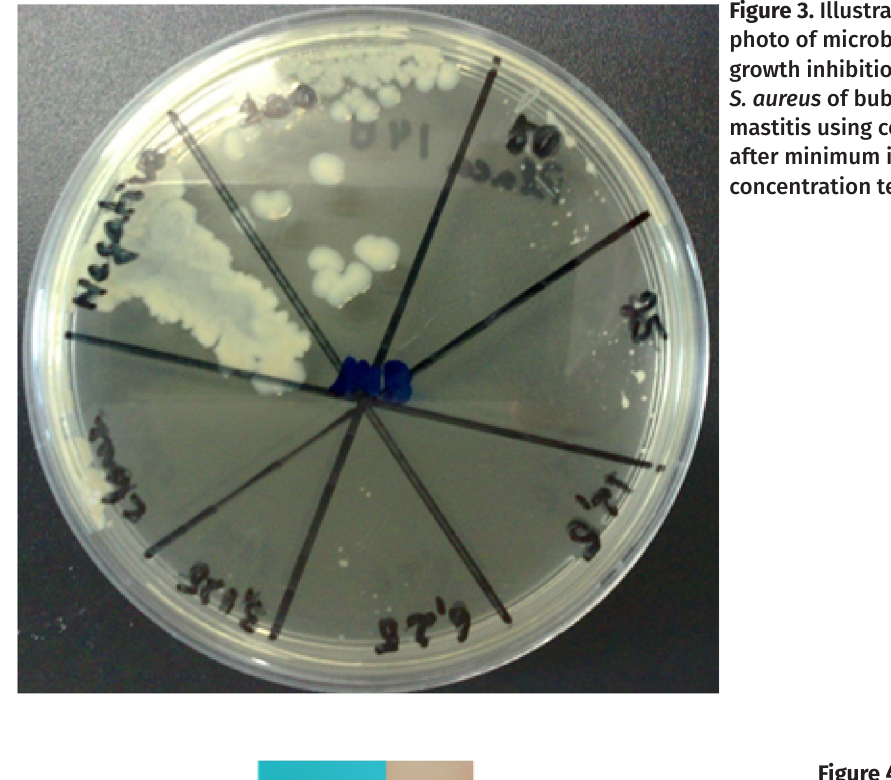
Figure 4. a - Chromatography of copaiba oil eluted with hexane (8): ethyl acetate (2). b - Fraction of copaiba oil with antimicrobial activity after addition of Liebermann